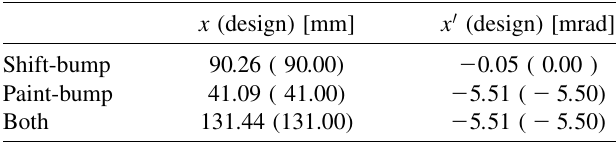
TABLE IV. Bump-orbit summaries at the injection point ( s (cid:4) 82 : 113 m ) with the shift-bump and paint-bump